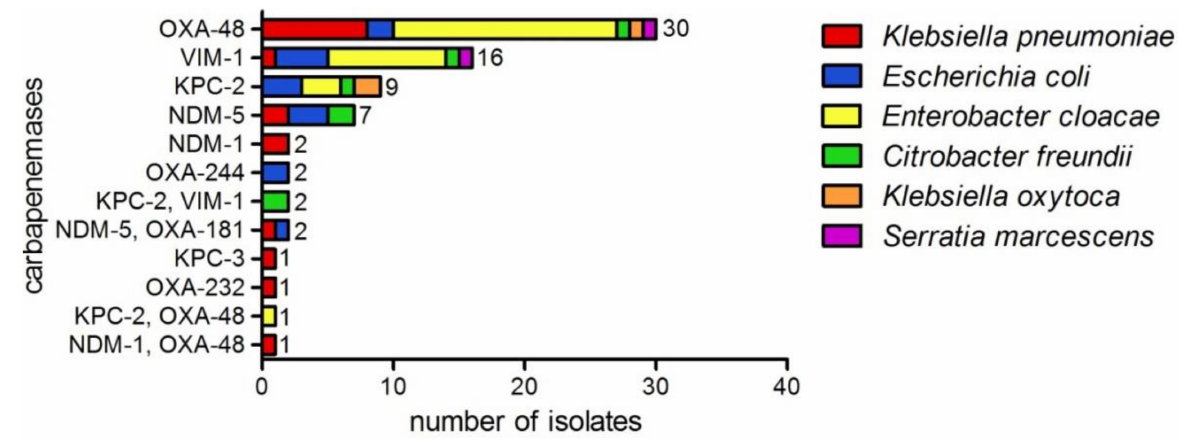
Figure 1. Carbapenemases detected in Enterobacterales by WGS ( n = 74), showing phenotypic resistance to carbapenem antibiotics. E. cloacae (n=30), K. pneumoniae ( n = 17), E. coli ( n = 15), C. freundii ( n = 7), K. oxytoca ( n = 3) and S. marcescens ( n =